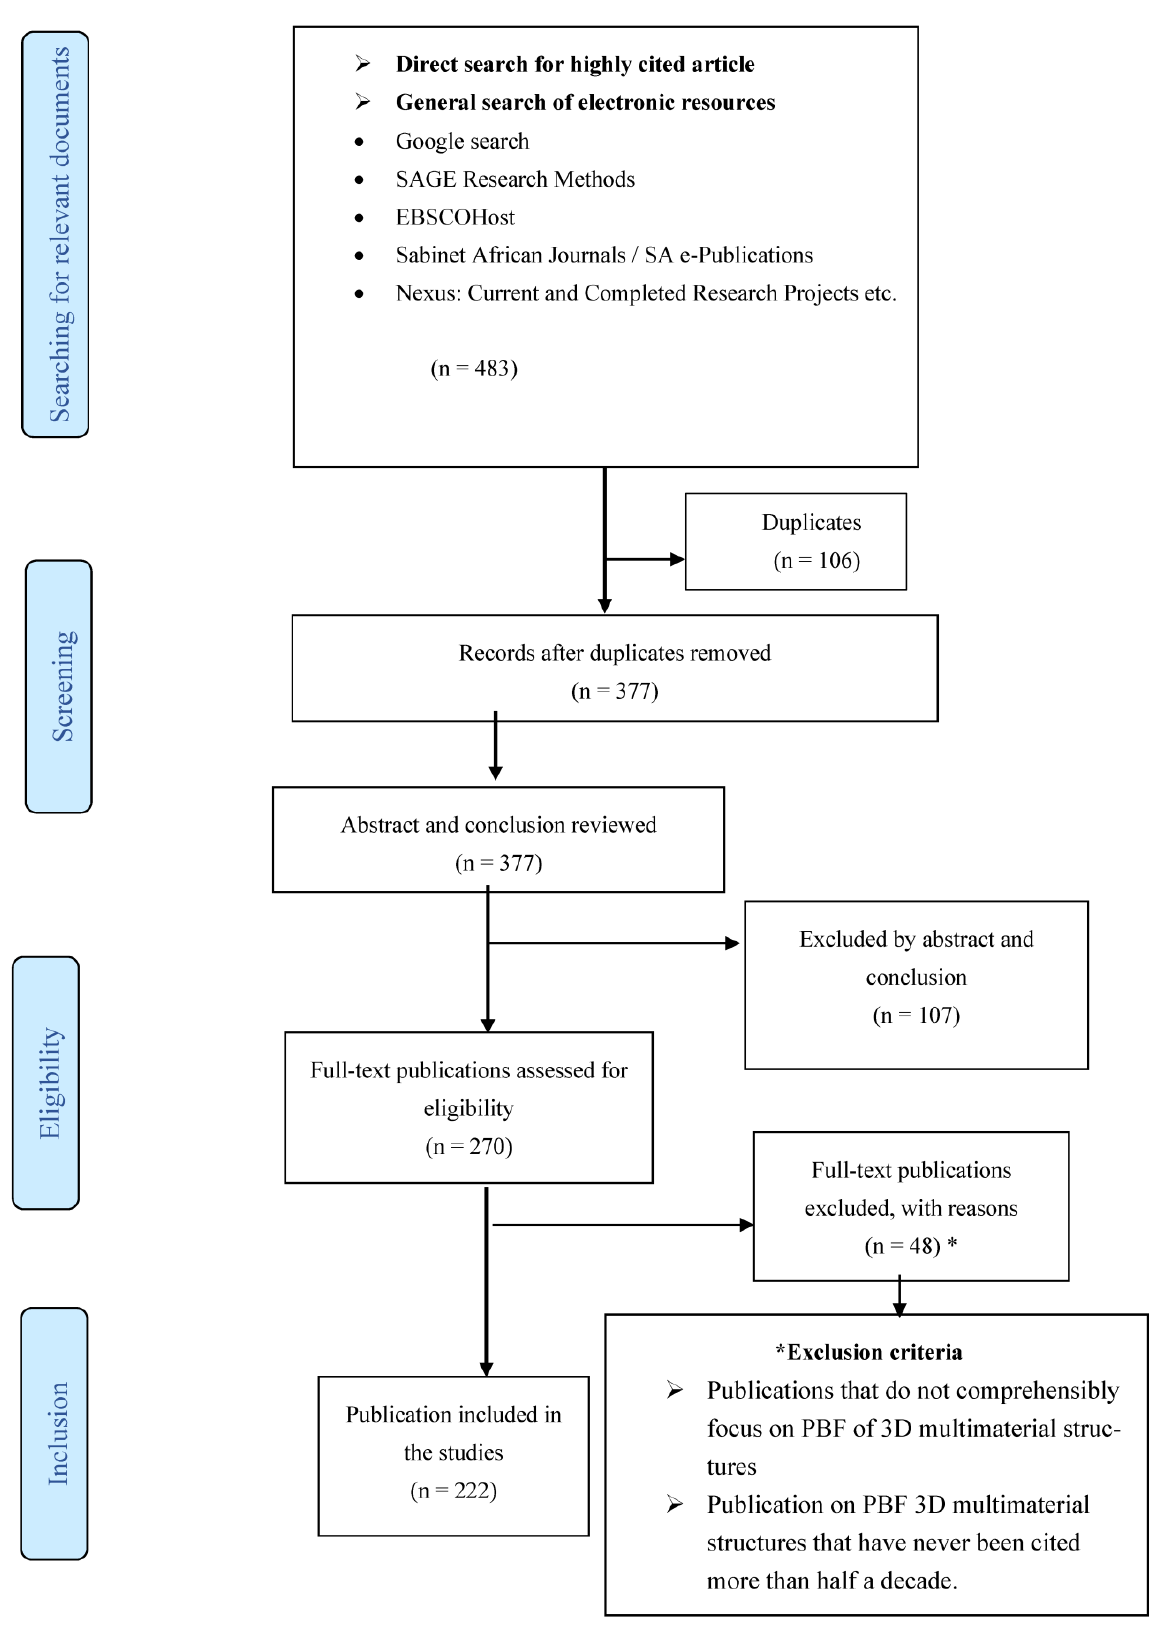
Figure 1. Flow chart for exclusion and inclusion of published articles (* explanation to the exclusion criteria).